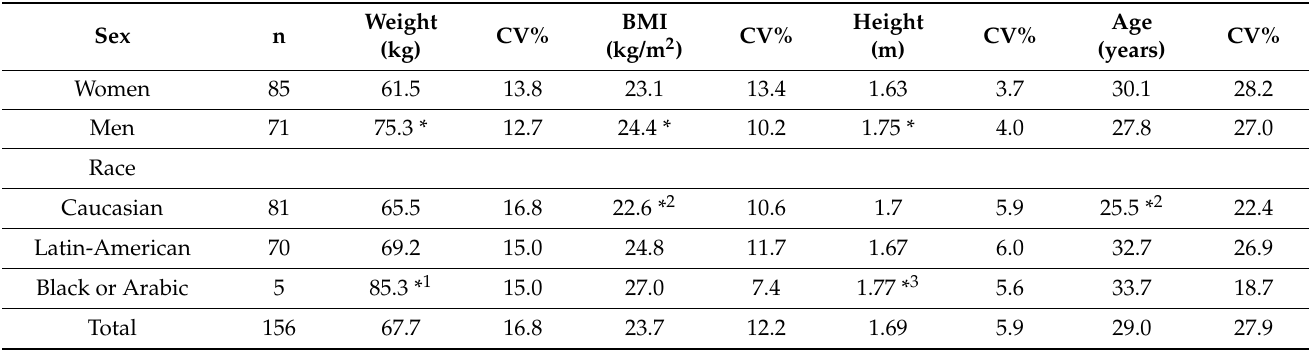
Table 2. Demographic characteristics of the study